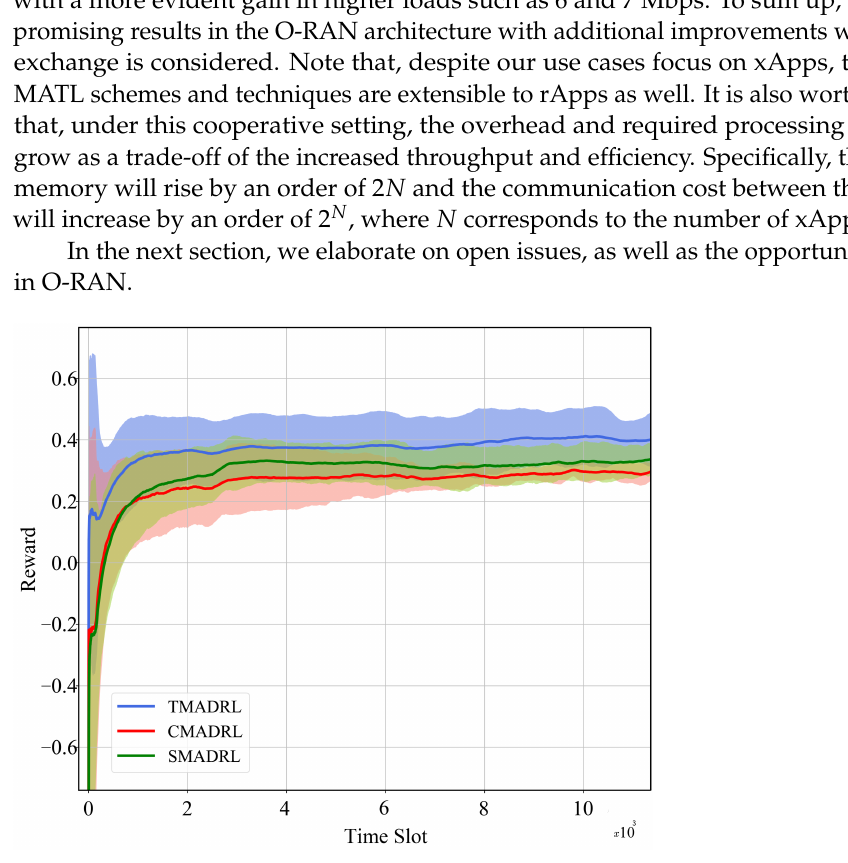
Figure 4. Learning convergence for the TMADRL, CMADRL and SMADRL schemes.